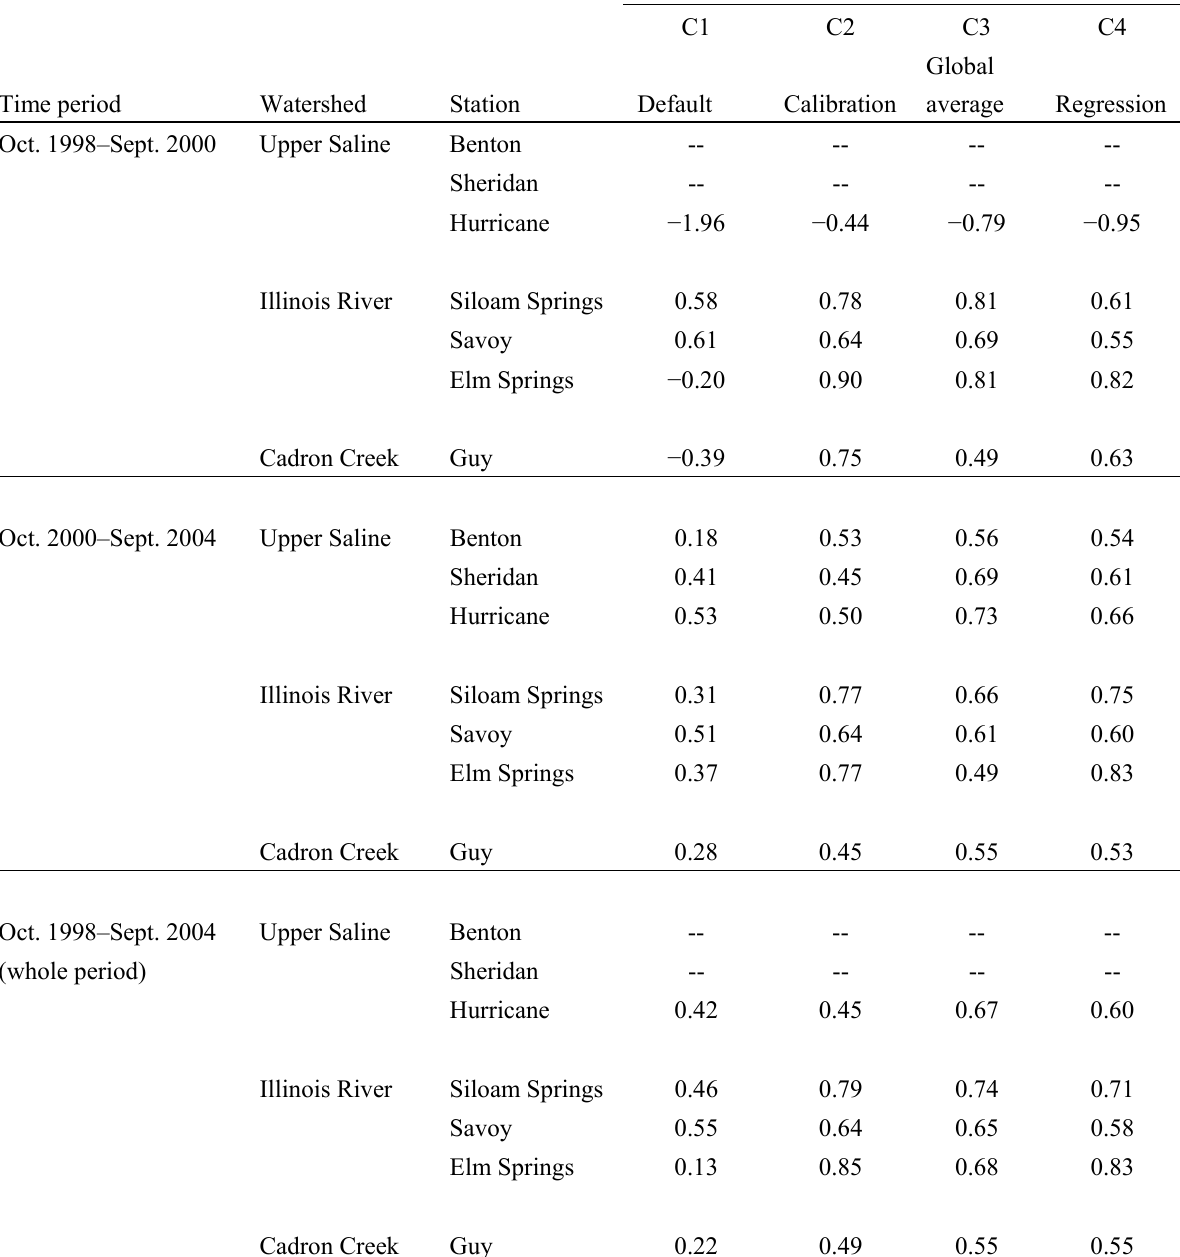
Table 4. Global average and regression-based parameters monthly performance in comparison to performance based on calibrated